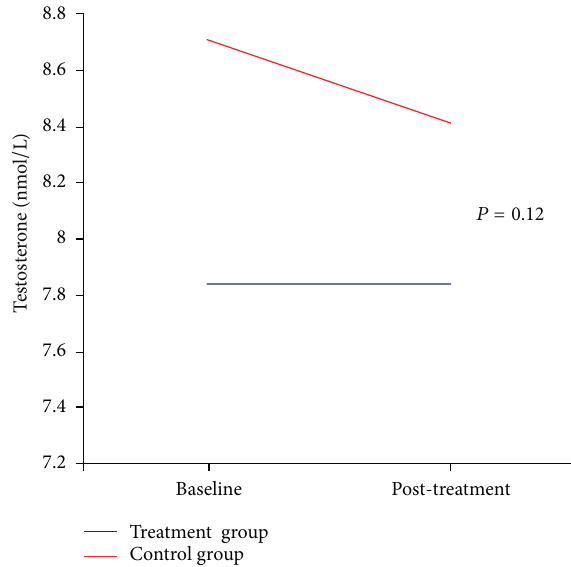
Figure 1: Changes in Testosterone levels at baseline and after treatment. Changes in the average Testosterone levels (nmol/L) before (baseline) and after (post-treatment) magnesium sulfate administration (blue line) and placebo (red line). The difference in total Testosterone levels between the 2 groups touched the statistical significance ( 𝑃 = 0.12